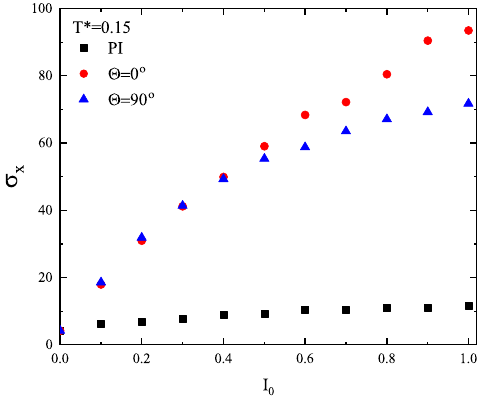
Figure 10. Plot of standard deviation σ x , Equation (5), for FPM with linear polarizations Θ = 0 ◦ (red circles) and 90 ◦ (blue triangles). Black squares, PI